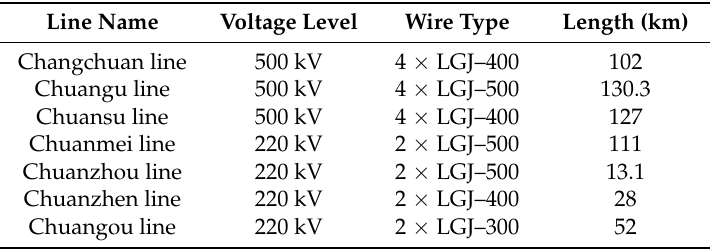
Table 2. Parameters of the icing lines in the Chuanshan